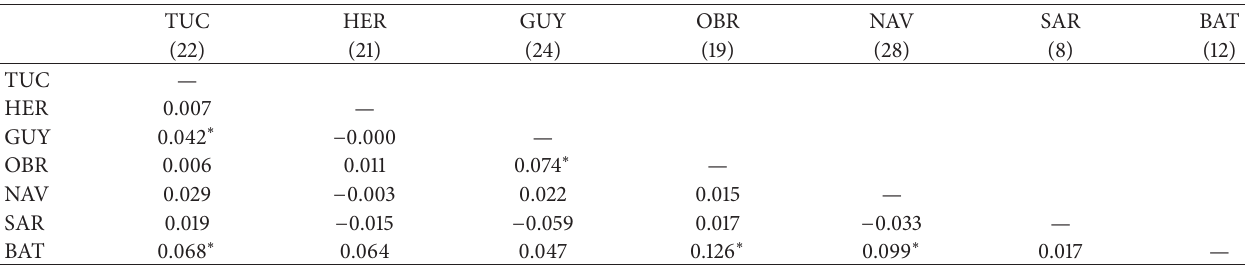
Table 3: Pairwise comparisons of 𝐹 for populations of Culex quinquefasciatus from the Sonoran Desert region based on analyses of four ST microsatellite loci. Sample sizes from each locality are shown in parentheses. Locality abbreviations are given in the legend of Figure